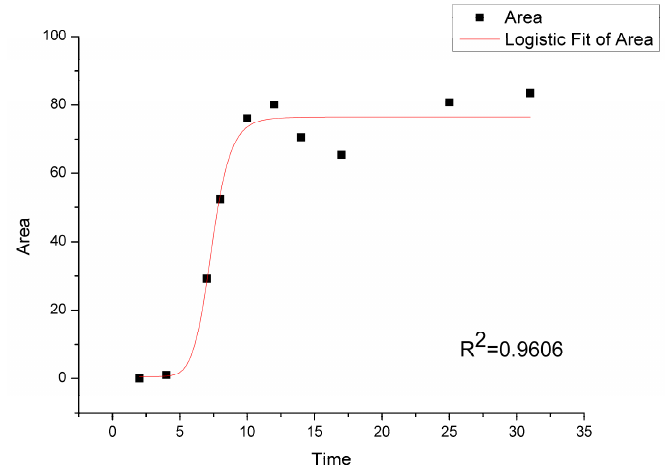
Figure 12. Graph of logistic fitting of the canopy area of the single plant from 2 April to 1 May 2019 Table 6. Summary of the results of logistic fitting of the sakura region.